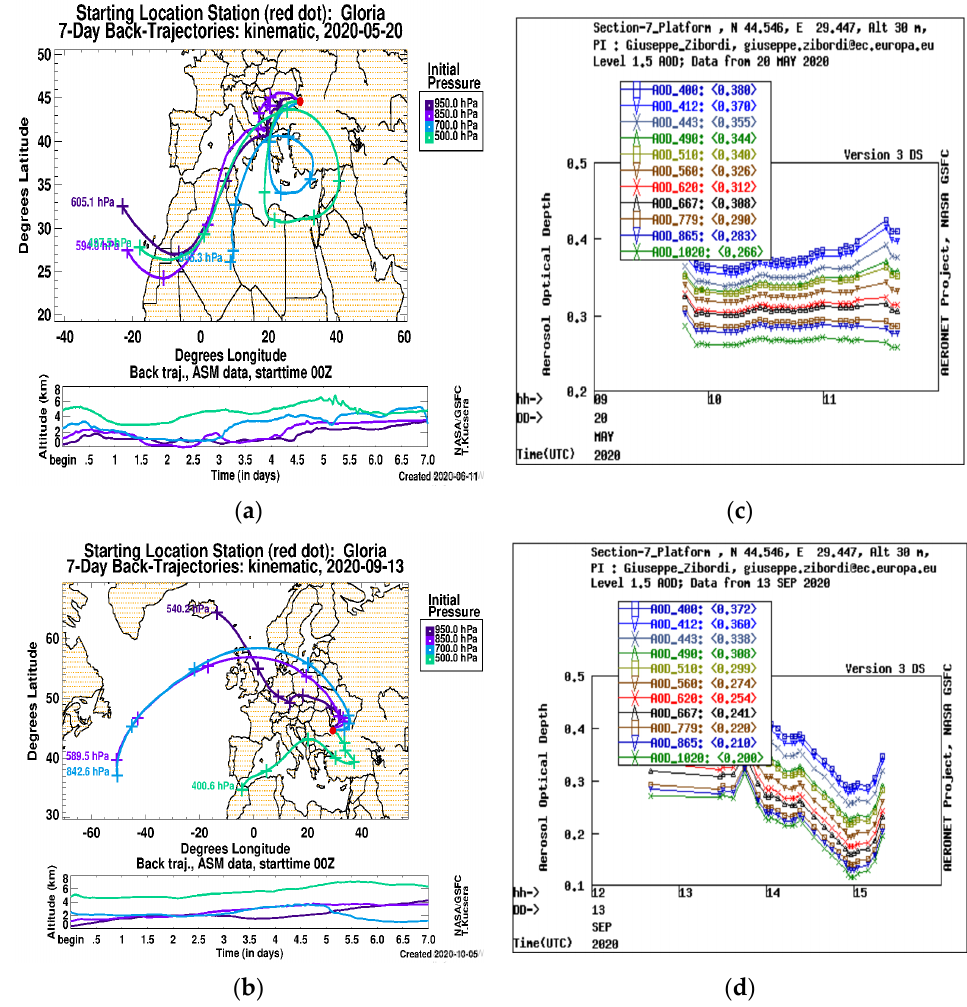
Figure 2. Backward trajectories of AERONET (20.05.2020 ( a ), 13.09.2020 ( b )) and the corresponding dynamics of the change in the AOT on the days of dust transport predicted by the WRF-Chem model (20.05.2020 ( c ), 13.09.2020 ( d )).